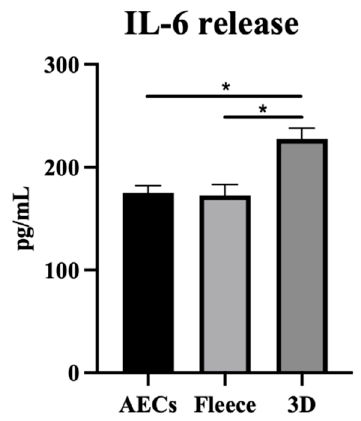
Figure 10. Effect of CM on IL-6 levels released from THP-1 macrophages was evaluated by ELISA. The IL-6 levels in supernatants were analyzed after 24 h treatment through ELISA assay. * Statistically significant values between the different studied groups ( p < 0.01).